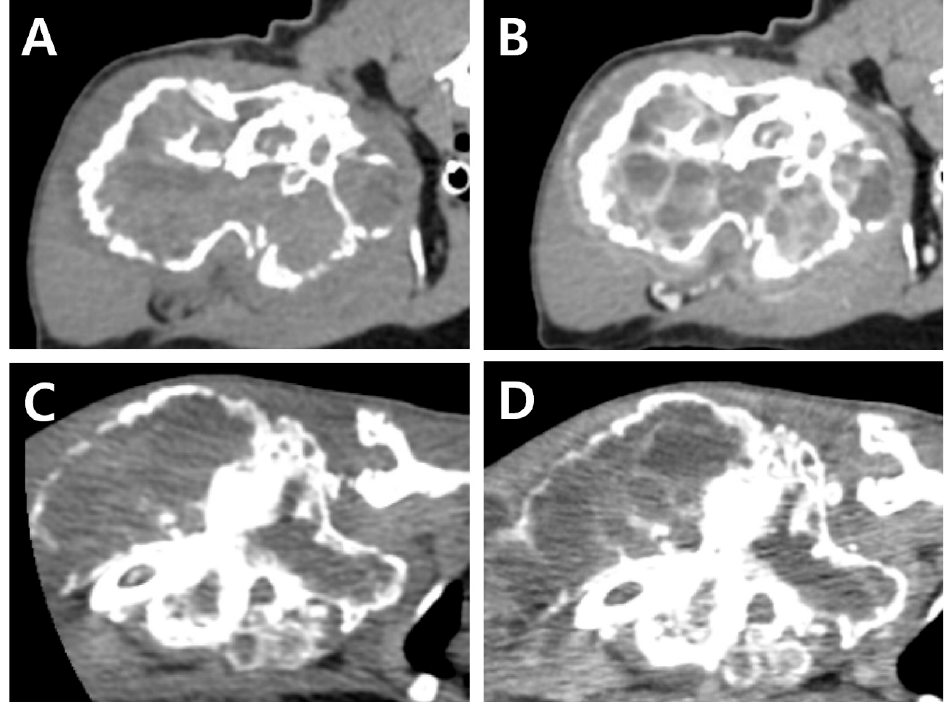
Figure 2. CT images at initial presentation ( A , B ). Pre-contrast image ( A ), post-contrast image showing contrast-enhancement of the surrounding tissues and vessels within the mass ( B ). CT Images at the second presentation (4 months after initial presentation) ( C , D ). Pre-contrast image ( C ), and post- contrast image ( D ). Note, regardless of the change in the size of the mass, fluid attenuating cystic lesion with rim enhancement of margin and internal septa are consistently identified.